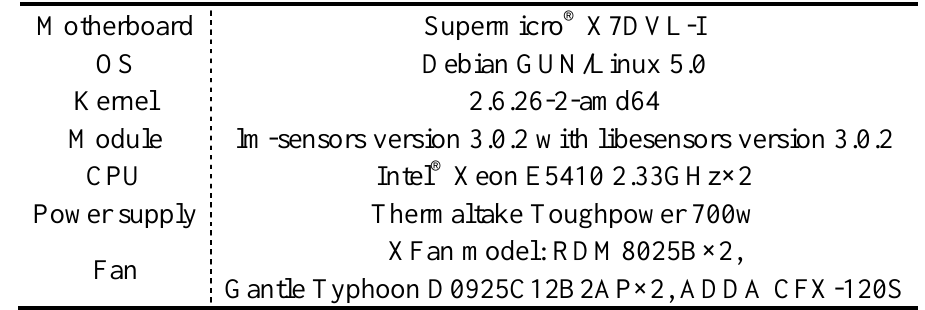
Table 1. Server specification.